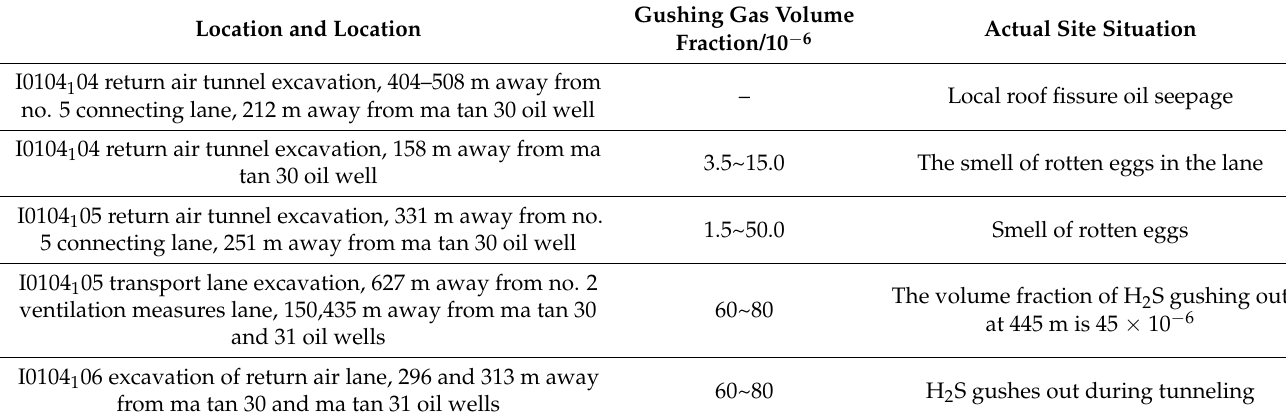
Table 1. Statistics of H 2 S emission at different positions of the tunneling face.